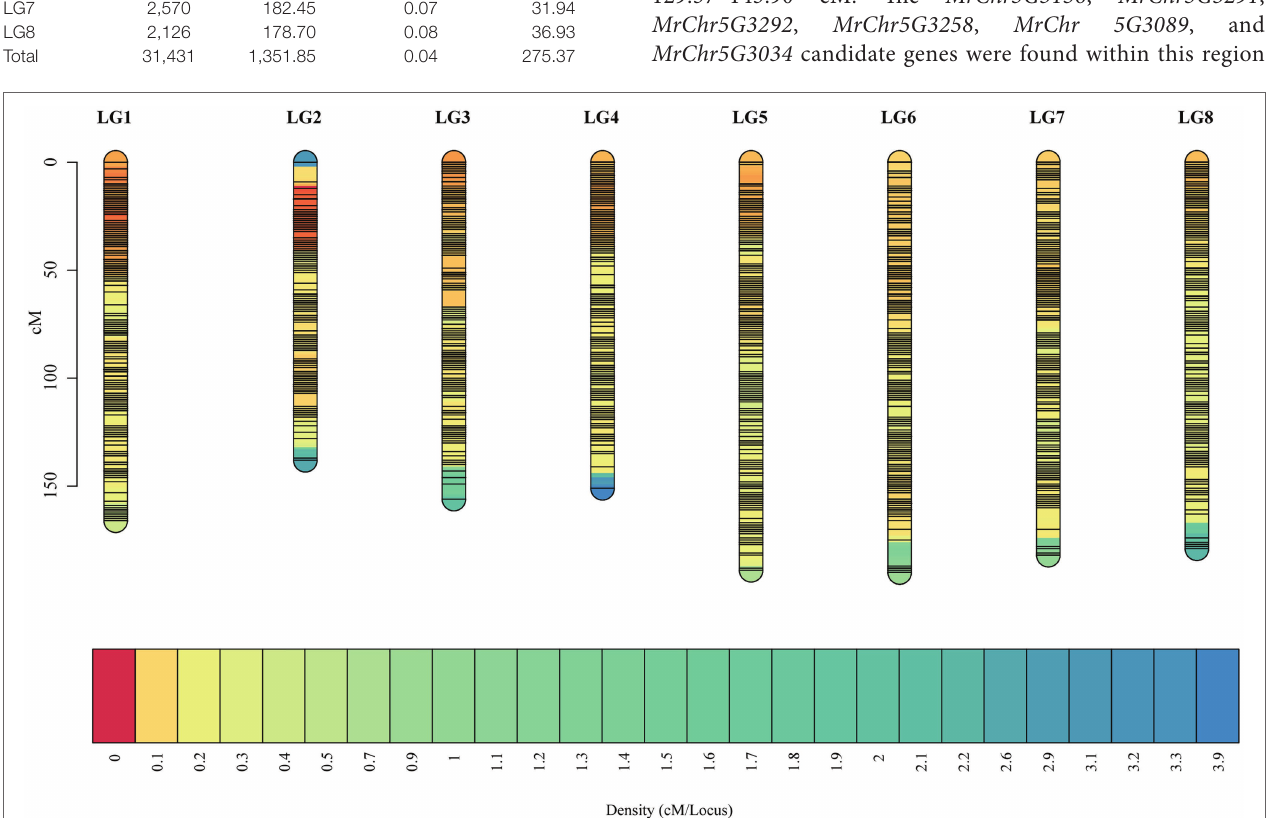
FIGURE 2 | The high-density F 1 population-based integrated genetic map. The x -axis corresponds to the linkage group, and the y -axis corresponds to the location, with marker density increasing gradually from red to blue.